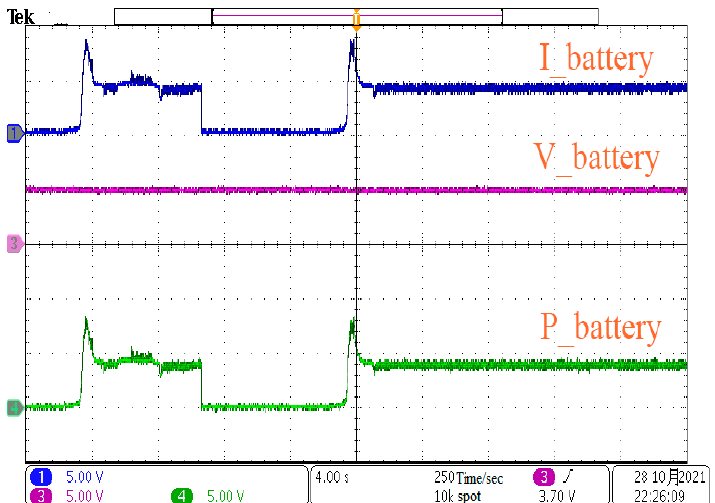
Figure 23. The first PV array’s current, voltage, and power under load constant and radiation changes; ( 月 is month).